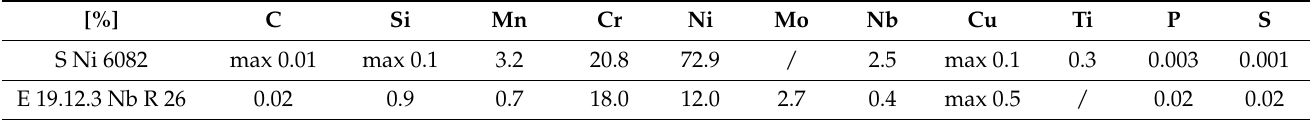
Table 2. Chemical compositions of the filler metals.